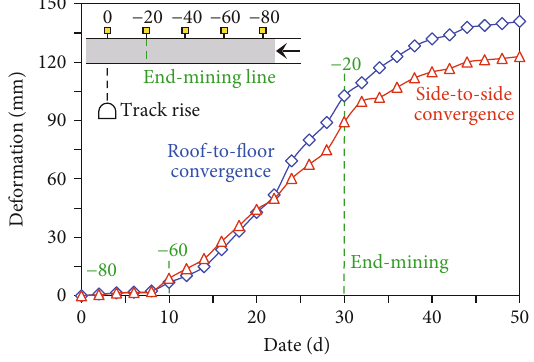
Figure 11: The variation in the convergence of roadway